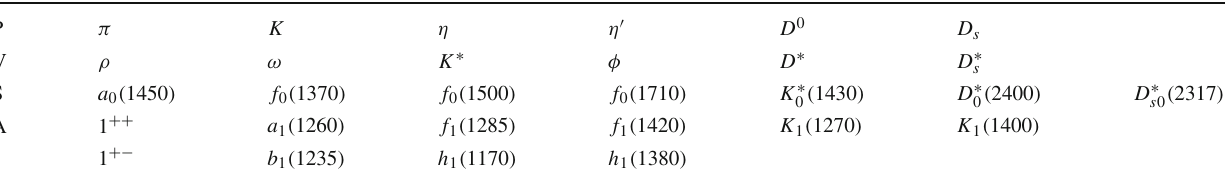
Table 3 The involved mesons in the semileptonic B and B s decays, where P , V , S , A denotes the pseudoscalar, vector, scalar (mass above 1 GeV), and axial-vector mesons, respectively. In the axial-vector